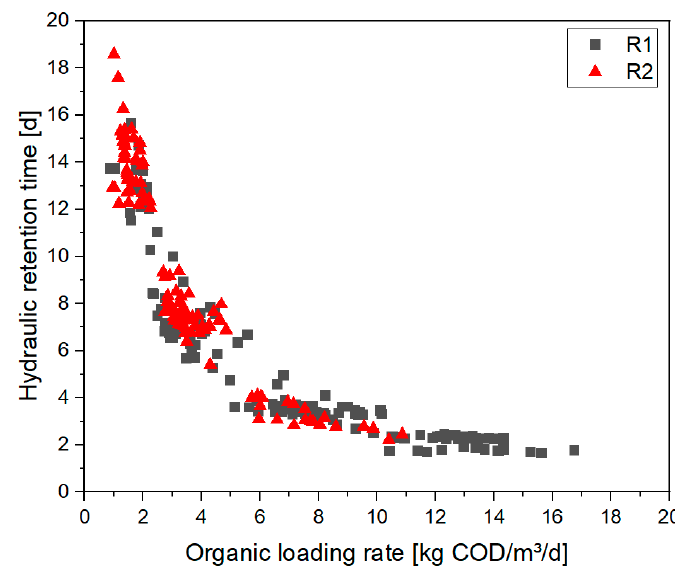
Figure 5. Correlation between the OLR and HRT.